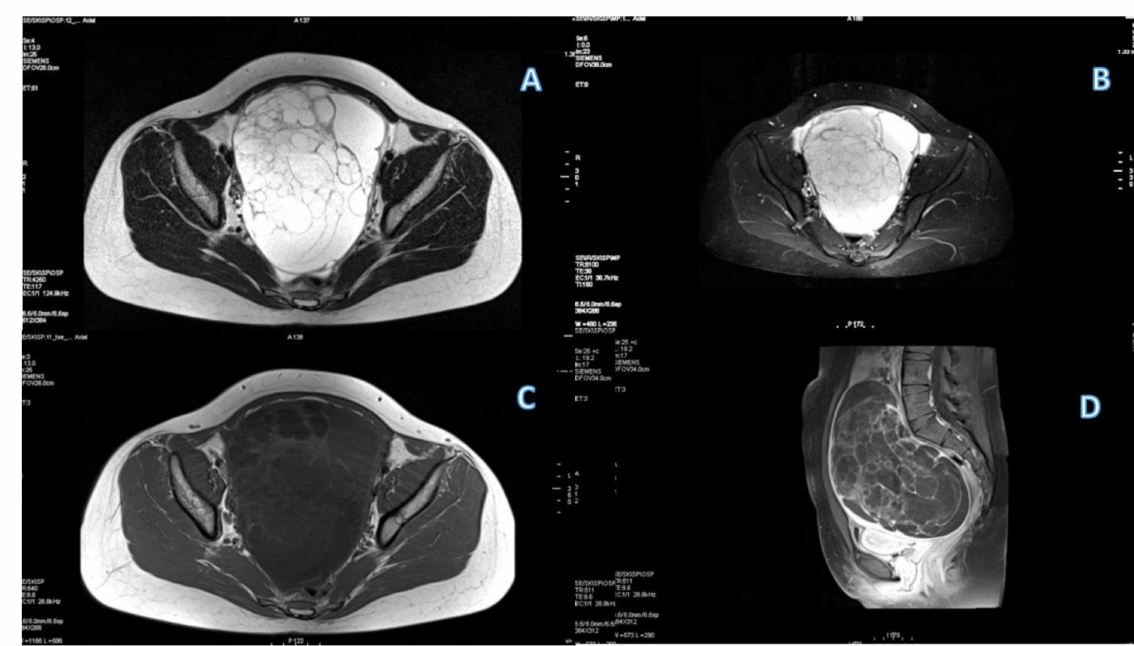
Figure 4. Images from a 24-year-old woman with mucinous ovarian cancer (MOC). A large pri- mary multilocular cystic tumor was imaged with differing signal intensities of the cyst-on axial T2-weighted ( A ); on T2 STIR ( B ); on T1-weighted ( C ) and sagittal T1-weighted postcontrast fat- saturated subtracted MR show enhancement with solid part of the tumor ( D ).